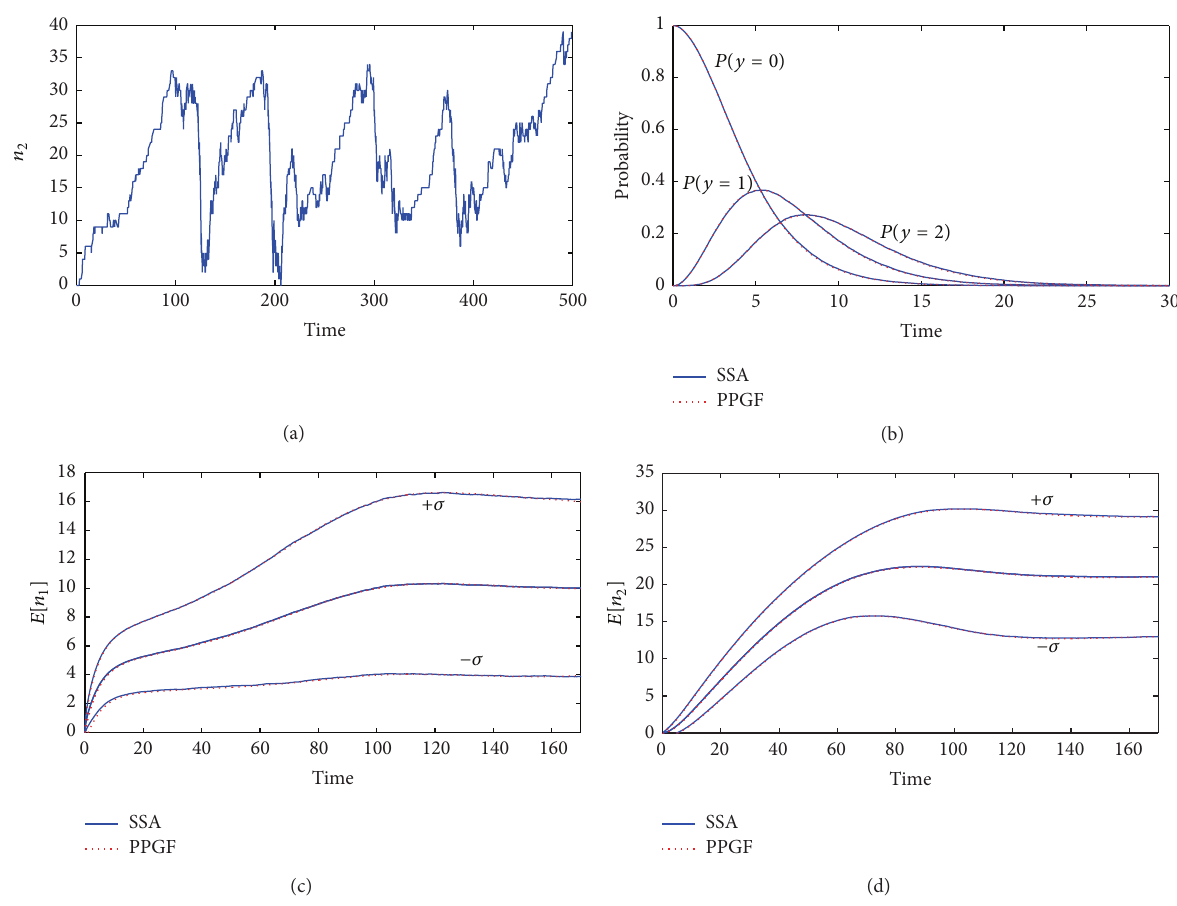
Figure 2: Comparison of mean and standard deviation for the Brusselator model. The initial condition 𝑛 1 (0) = 0 and 𝑛 2 (0) = 0 are assumed. (a) shows a typical run of 𝑌 in 500 seconds from a Monte Carlo simulation of the Brusselator model. In (b), 𝑃(𝑦 = 𝑖) denotes the probability that the number 𝑛 2 of the substrate is 𝑖 . (c) and (d) compare mean and mean ± standard deviations ( ±𝜎 ) of 𝑛 1 , 𝑛 2 , and 𝑛 3 obtained from the SSA and the PPGF. The results from the SSA are based on 50,000